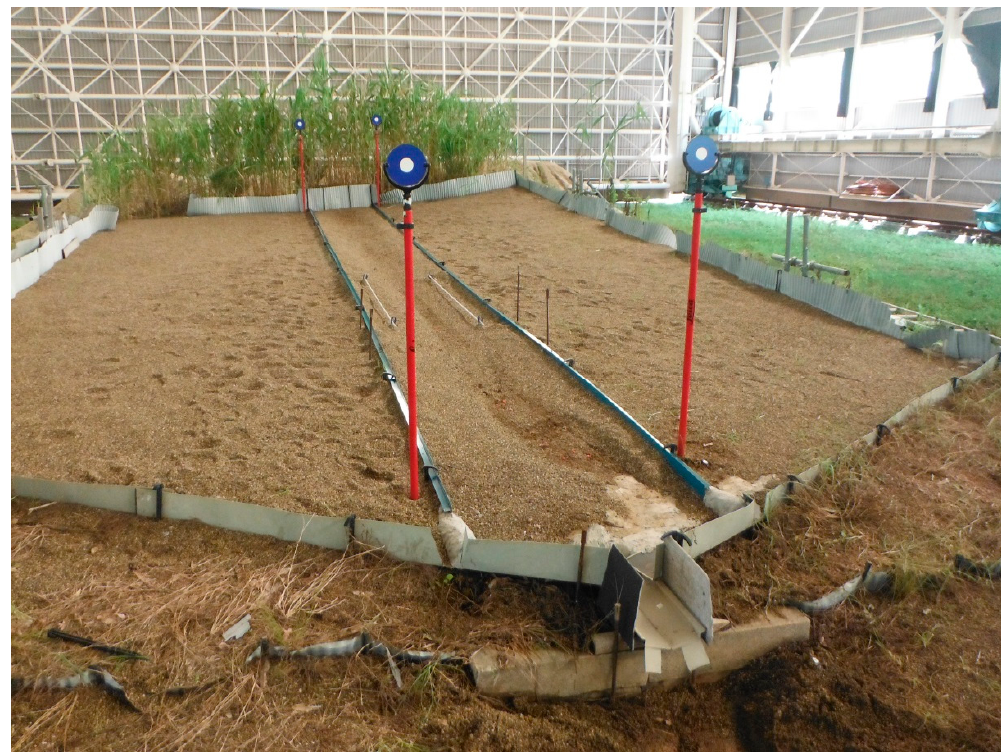
Figure 2. The 1-m-wide plot used for the second experiment, showing also the surface layer of gravel used for both experiments.